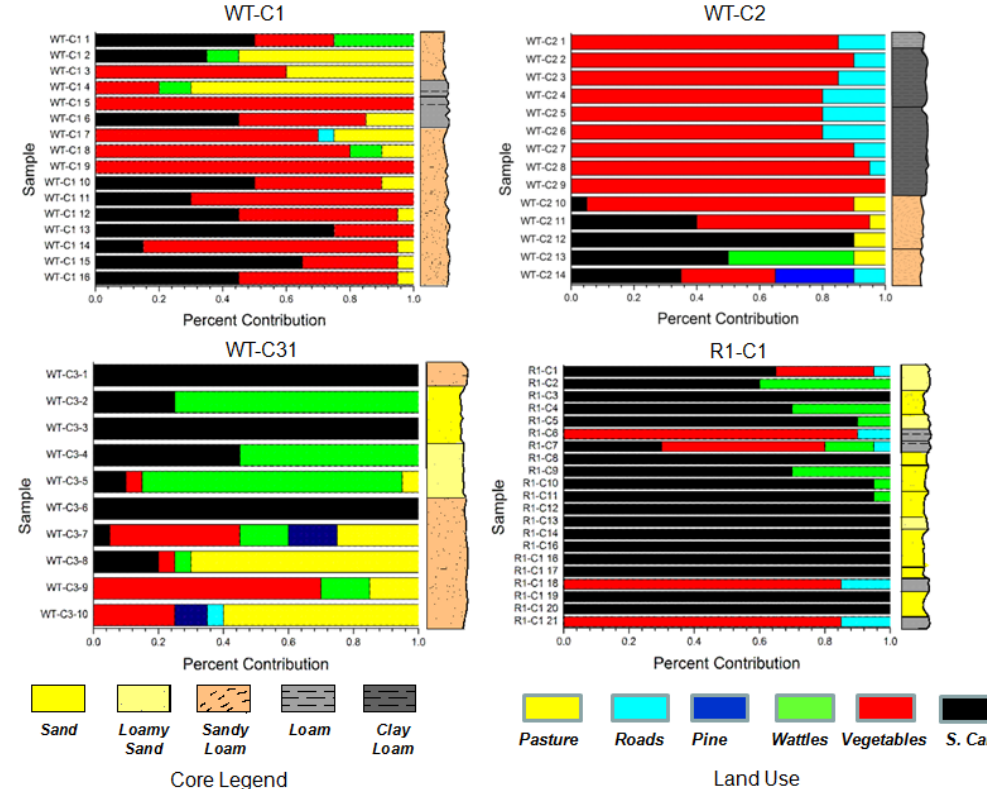
Fig. 8. Relative percent of sediment derived from specific land-use types within the